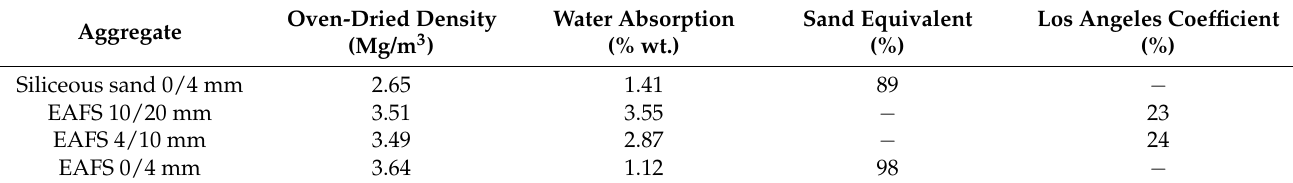
Table 1. Physical properties of aggregates.